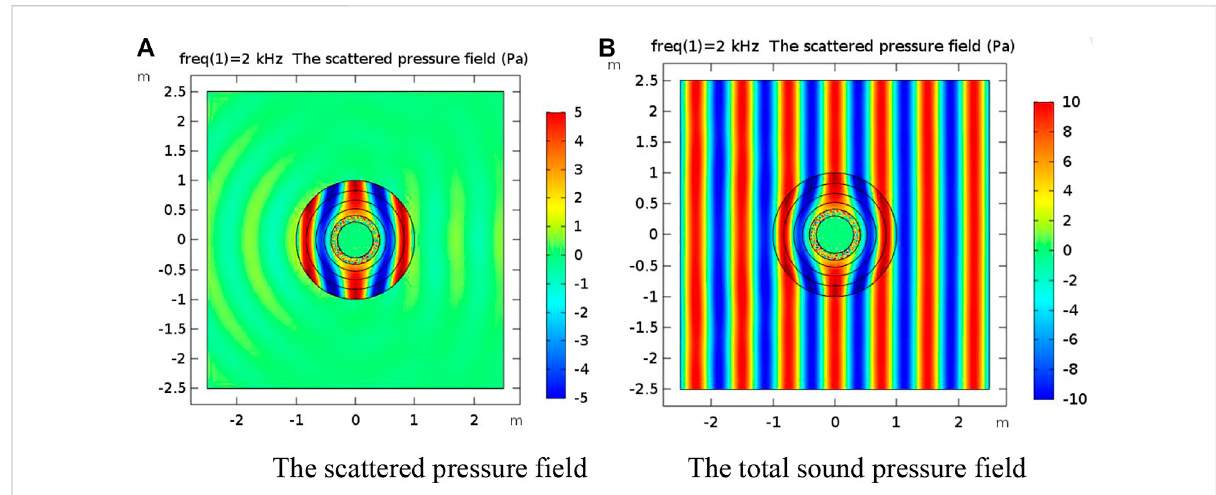
FIGURE 8 (A) The scattered pressure fi eld after cloak structure optimization. (B) The total sound pressure fi eld after cloak structure